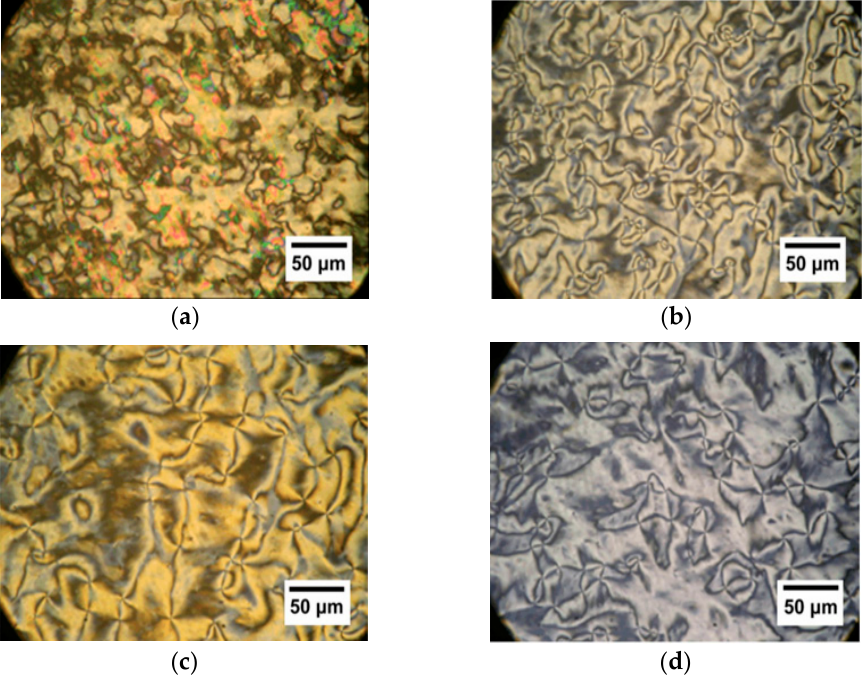
Figure 11. The optical photomicrograph of ( a ) 9a at 150 °C, ( b ) 9b at 155 °C, ( c ) 9c at 160 °C and ( d ) 9d at 166 °C. Reprinted/adapted with permission from Ref. [45]; published by Elsevier, 2010. Jamain et al. (2020) synthesized cyclotriphosphazene derivatives 10(a – j) with two